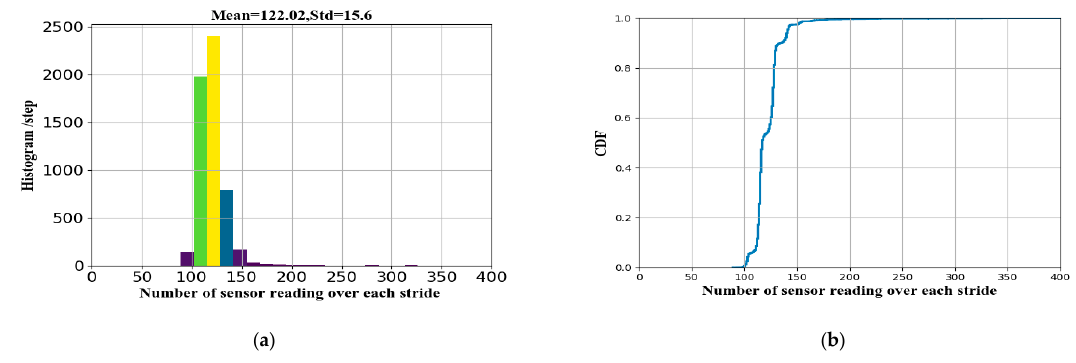
Figure 4. Distribution of sensor-reading number over each stride. ( a ) histogram; ( b ) cumulative distribution.